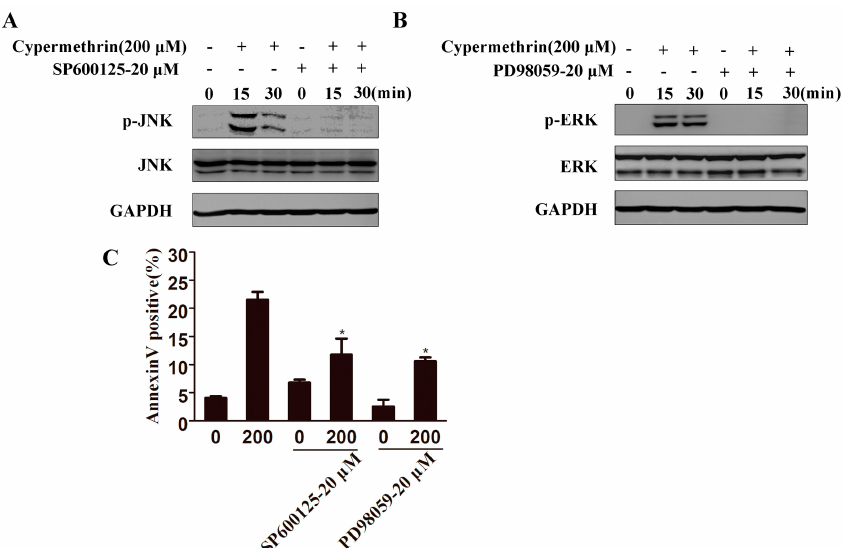
Figure 6. Treatment of cells with JNK/ERK-MAPK specific inhibitor prevented cypermethrin-induced apoptosis. ( A )RAW cells were treated with JNK inhibitor (SP600125) or ERK1/2 inhibitor (PD98059) for 1 h prior exposed to cypermethrin (200 μ M). The levels of JNK and ERK phosphorylation were detected by Western blot analysis ( A , B ); Annexin V-FITC positive cells were analyzed by flow cytometry ( C ). Data were presented as means ± SD from three independent experiments.* p < 0.05 as compared with treatment with 200 μ M cypermethrin.